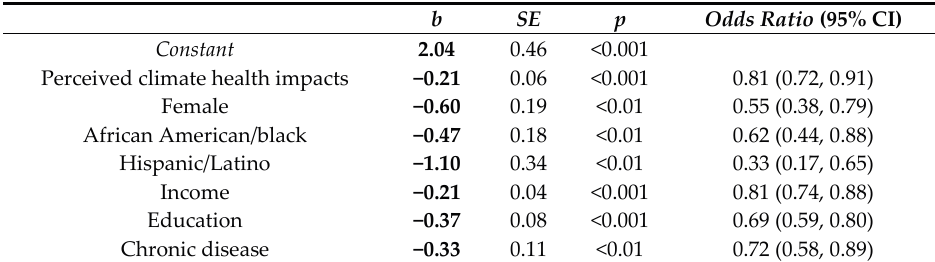
Table 4. Predictors of “don’t know” responses to perceived climate change health